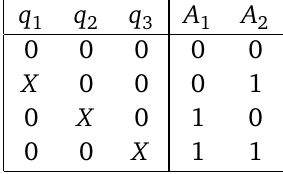
Table 1: Three-qubit error encoding ancilla results, for single bit-flip